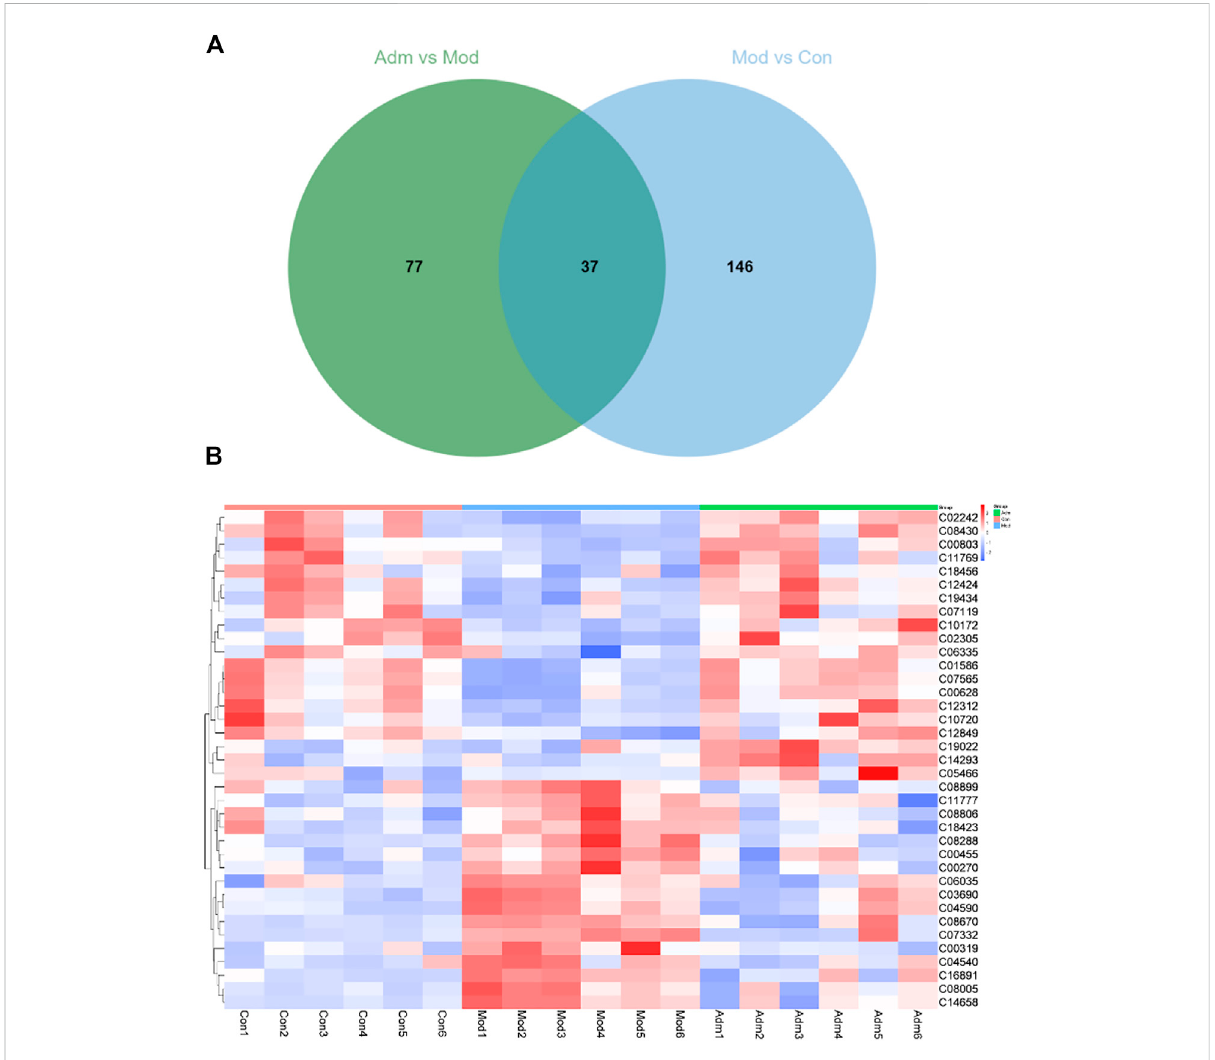
FIGURE 6 The differential metabolites in DFU rats treated with DP. (A) Venn diagrams of the common metabolites related to DFU and DP treatment. (B) The heat map of potential metabolites.